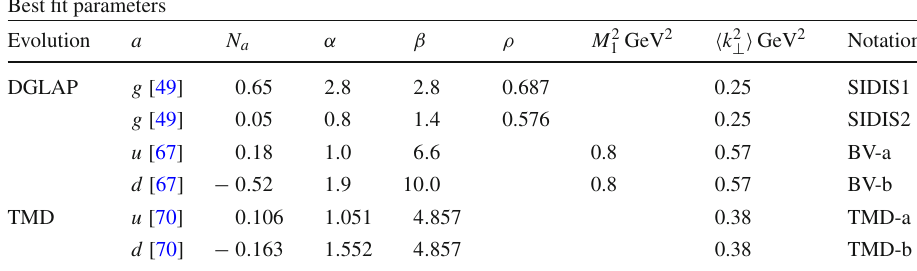
Table 1 The best fit parameters of the Sivers function